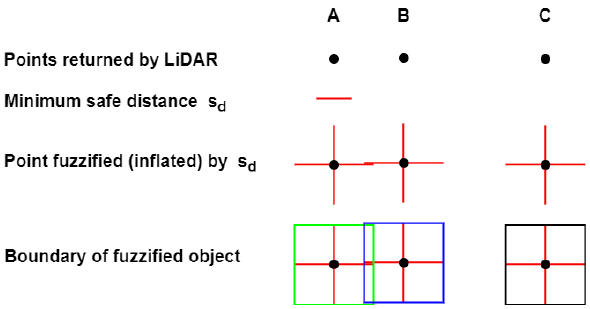
Figure 4. Concept of